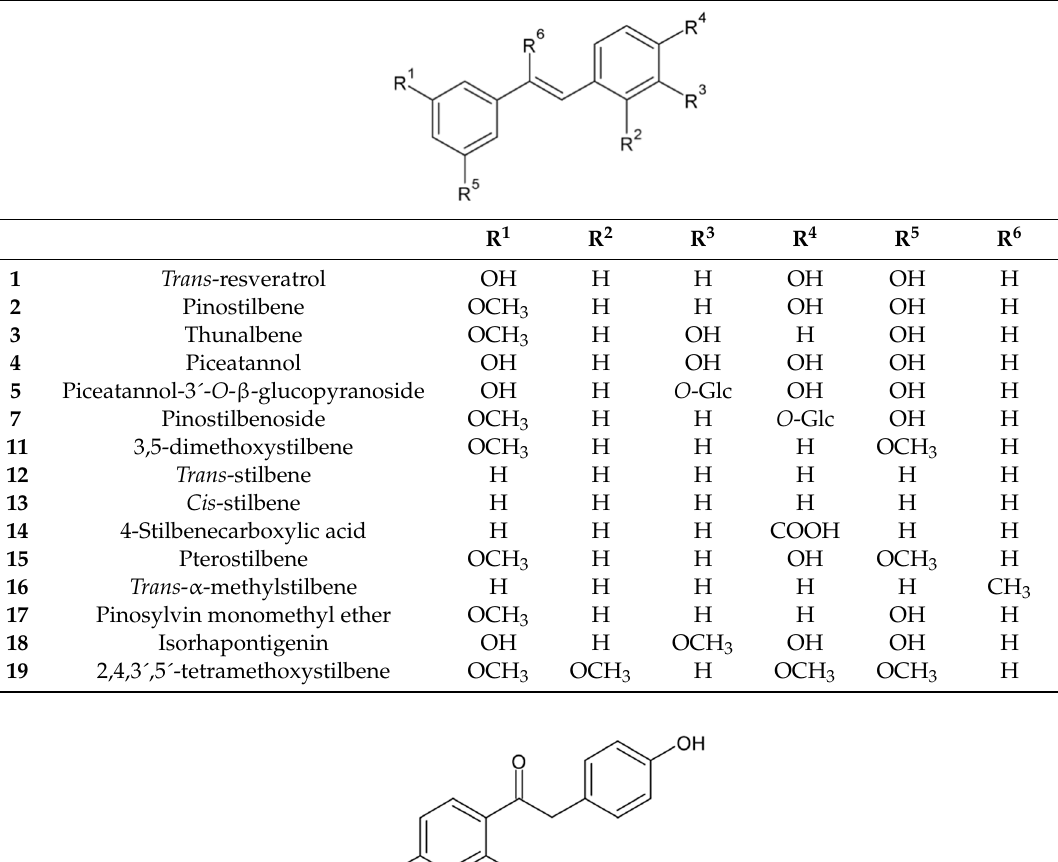
Table 1. Structures of the test stilbenoids.